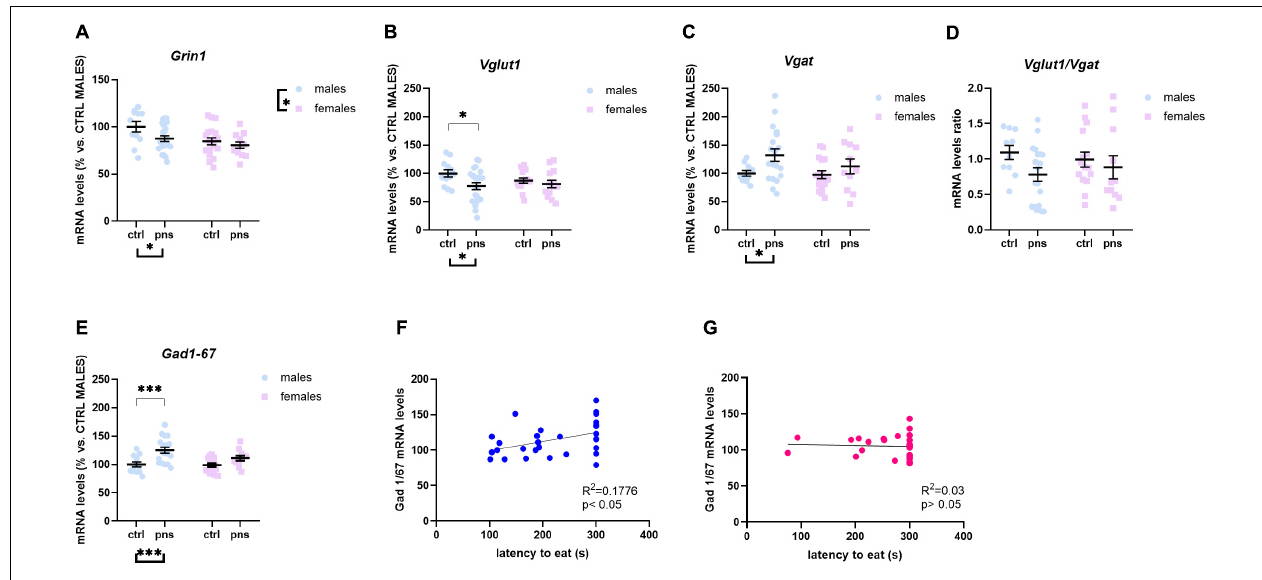
FIGURE 6 | Analysis of ( A ) Grin1 , ( B ) Vglut1 , and ( C ) Vgat mRNA levels; ( D ) Vglut1/vgat ratio; and ( E ) Gad 1/67 transcription levels in the amygdala of males and females exposed to prenatal stress. Data are expressed as a percentage of control males not exposed to stress (set at 100%) and represent the mean ± SEM of at least 10 independent determinations. Data information: symbols represent individual data. ∗ p < 0.05; ∗∗∗ p < 0.001 vs. control males (two-way ANOVA with Bonferroni’s multiple-comparison test). ( F ) Analysis by Pearson’s product–moment correlation (R 2 ) between Gad 1/67 messenger RNA levels and novelty-suppressed feeding (NSF) score of latency to bite. Data are expressed as scatterplots, with each dot representing either a control or PNS male rat for which Gad 1/67 mRNA levels could be quantified. The solid line represents the linear fit to all data points with 95% confidence interval. ( G ) Analysis by Pearson’s product–moment correlation (R 2 ) between Gad 1/67 messenger RNA levels and NSF score of latency to bite. Data are expressed as scatterplots, with each dot representing either a control or PNS female rat for which Gad 1/67 mRNA levels could be quantified. The solid line represents the linear fit to all data points with 95% confidence